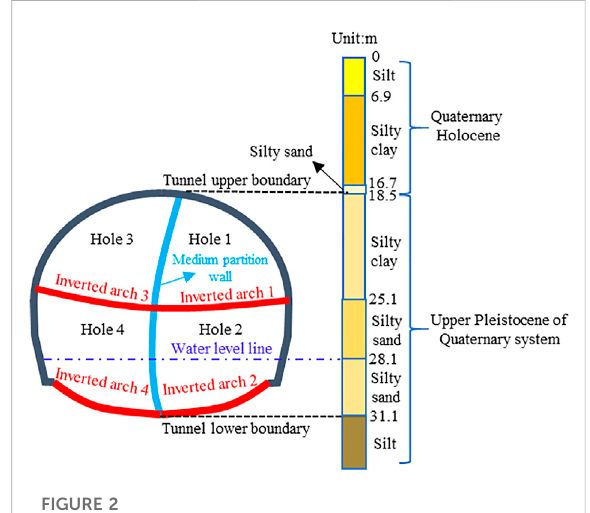
FIGURE 2 Location of the tunnel in relation to the strata.